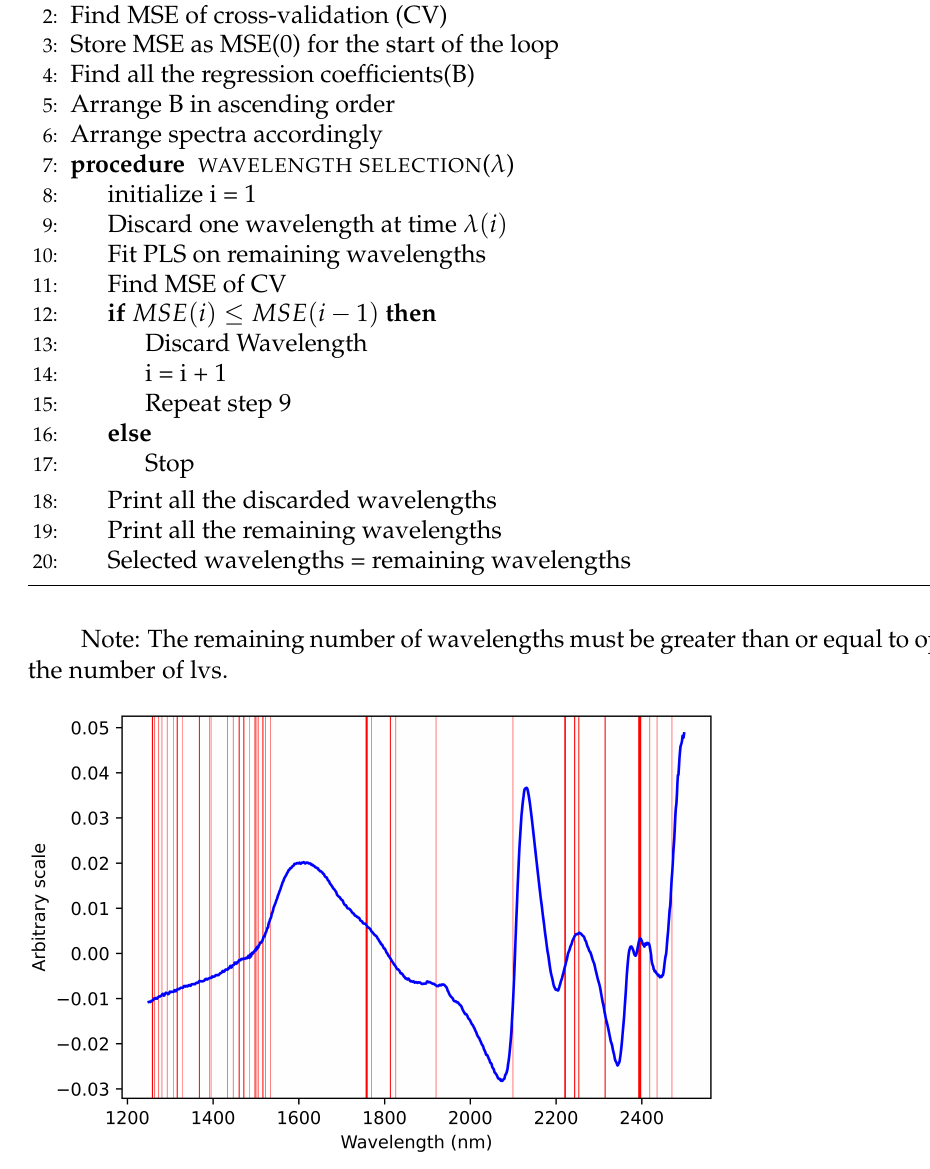
Figure 5. Selected bands of wavelengths for nitrogen